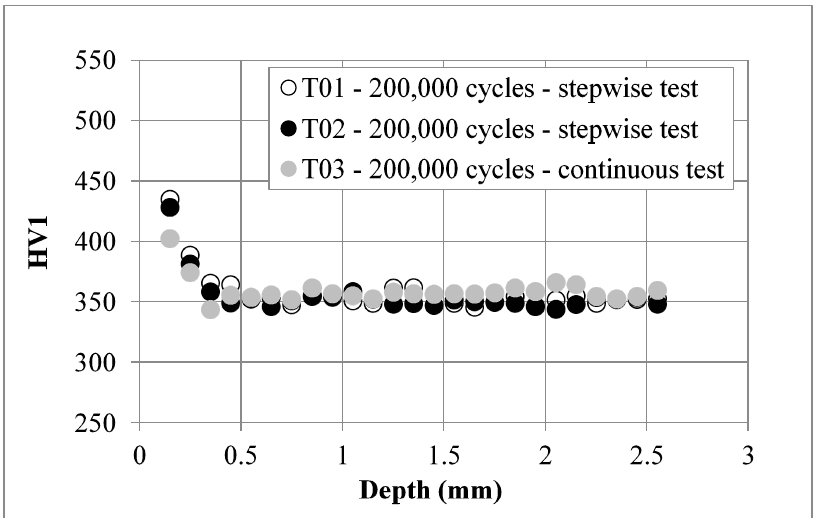
Figure 7. Vickers hardness as a function of the depth on the cross-section of the wheel discs for training tests.